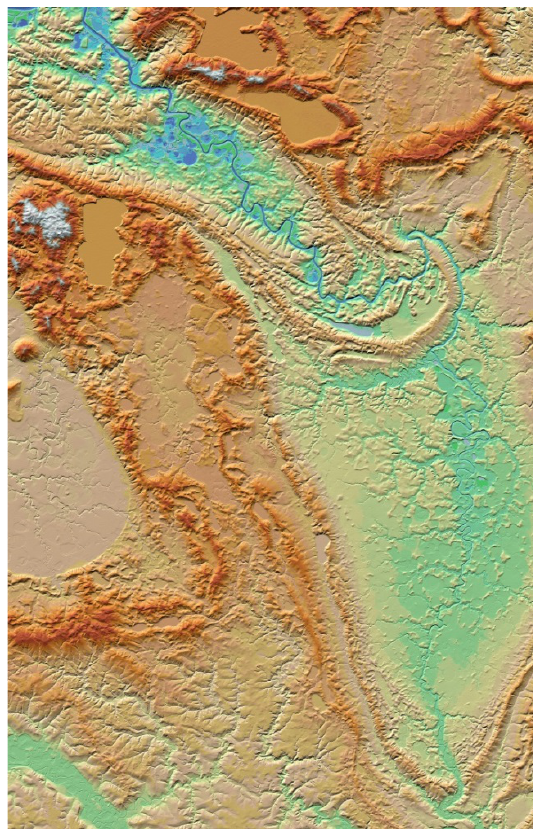
Figure 7. Final TanDEM-X DEM over North-Sibirian low